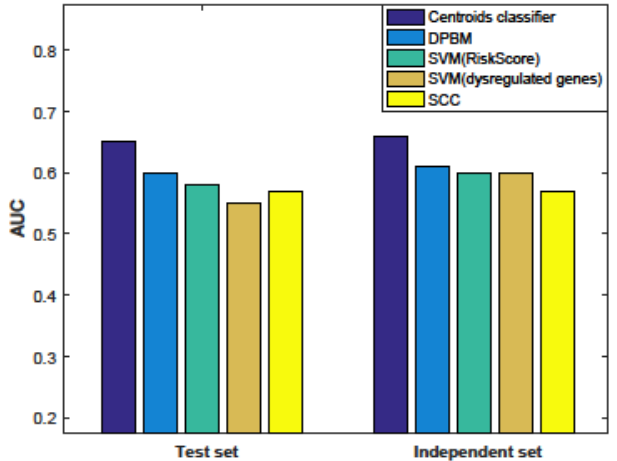
Figure 3. Comparing the performance of our method with published methods. AUC: area under the curve; DPBM: dysregulated pathway-based prediction model. SVM: Support vector machine; SCC: Shrunken centroids classifier.